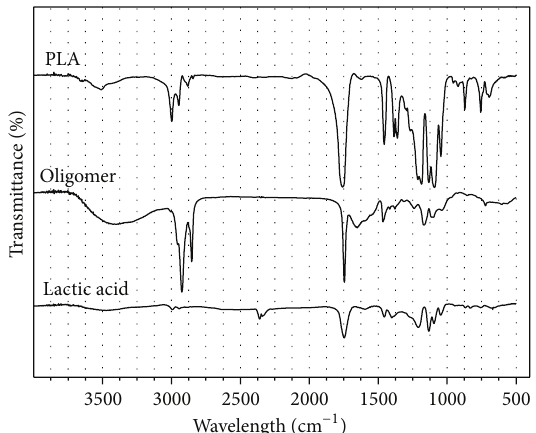
Figure 1: FTIR spectra of lactic acid produced by fermentation with L. delbrueckii and PLA synthesized.